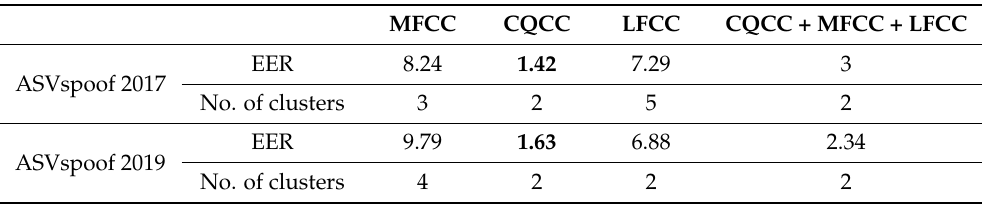
Bold number indicates the lowest EER value. Table 7. Achieved EER when using the GMM classifier and the learned number of clusters with respect to the considered features on the ASVspoof 2017 and ASVspoof 2019 benchmark datasets.